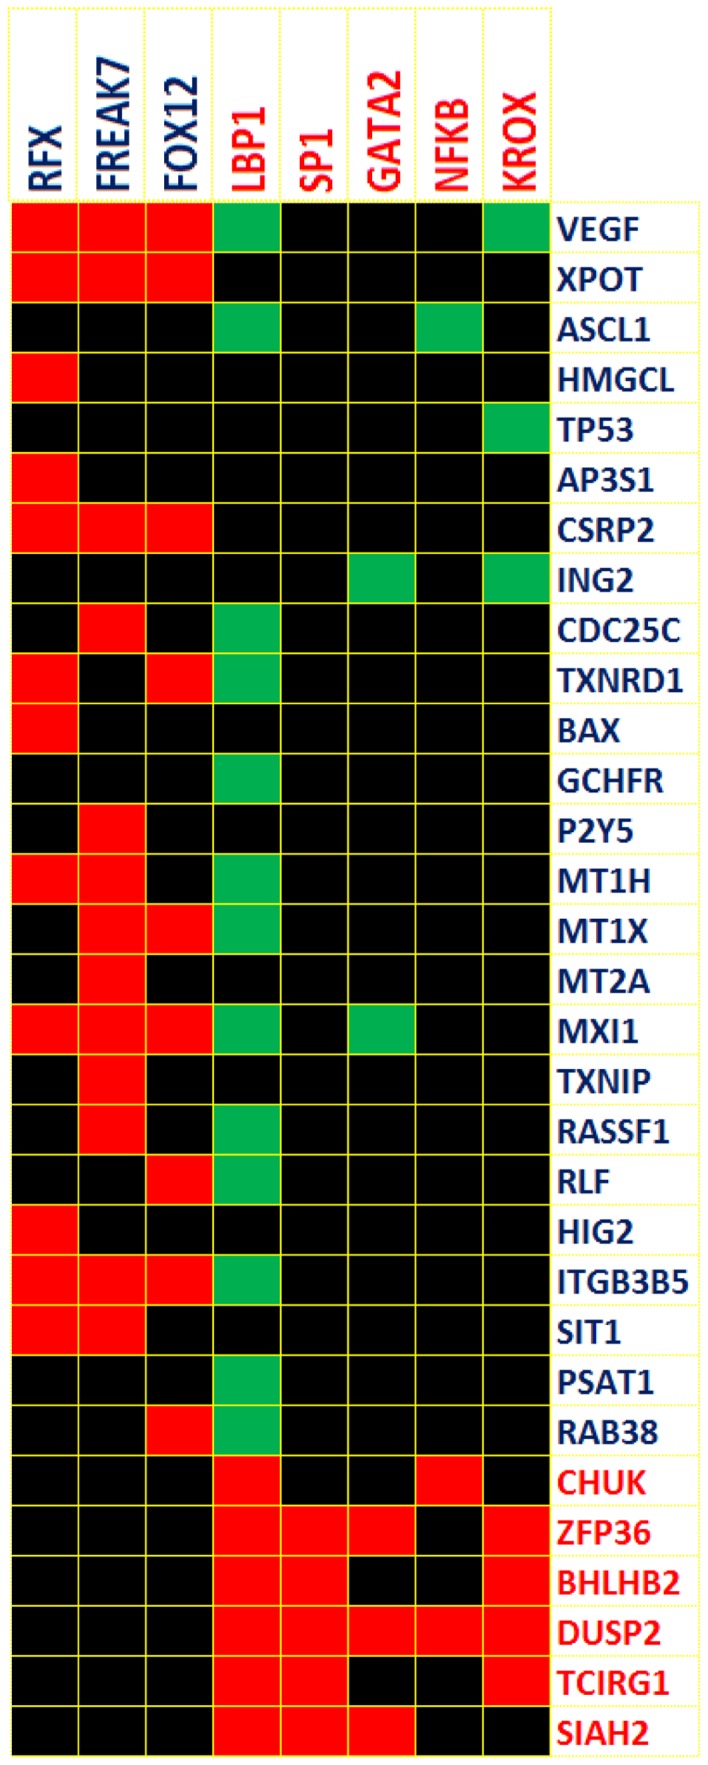
Transcription factor analysis of uniquely activated genes in control and SLE patient samples.The transcription factors tested are shown at the top of the figure. Blue text represents unique genes identified in control samples; while red text identifies unique genes identified in SLE patient samples. Individual elements of the matrix are colored by the significance of the p-values (threshold p = 0.05): over-representation in the matrix is indicated in red, under-representation is indicated in green.